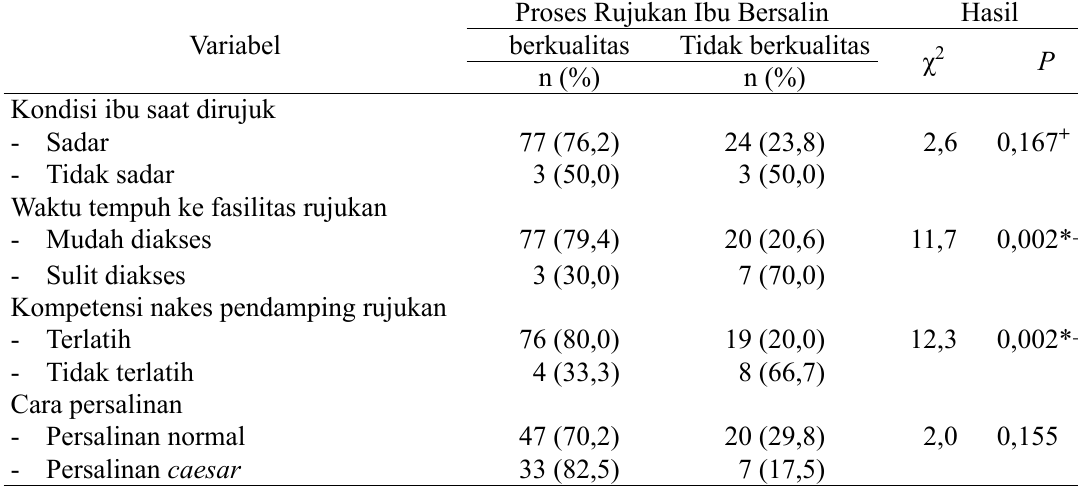
Tabel 5. Analisis chi square tabulasi silang kondisi ibu, waktu tempuh, kompetensi tenaga